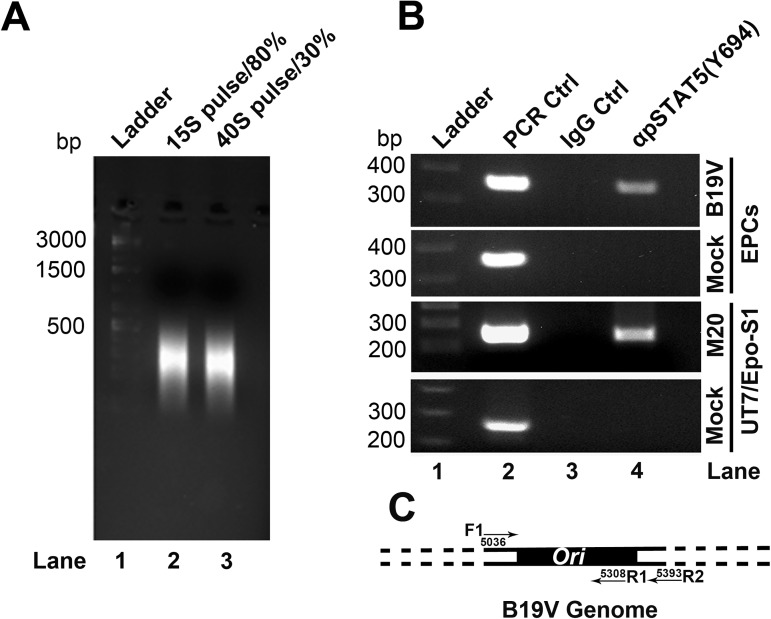
Chromatin immunoprecipitation (ChIP) assay.ChIP assay was performed using either infected CD36+ EPCs or transfected UT7/Epo-S1 cells, as indicated. (A) Crosslinked chromatin was sheared by sonication to sizes of ~500 bp. (B) An anti-pSTAT5(Y694) antibody or negative control IgG was used to pull down DNA-protein complexes. Recovered DNA from UT7/Epo-S1 cells or CD36+ EPCs was examined for viral DNA by PCR with primer sets of F1/R1 and F1/R2, respectively, which span the Ori sequences of the B19V genome. pM20 plasmid was used as a template for positive controls of PCR. (C) A diagram of the Ori-targeting PCR. The primers used for PCR are shown.